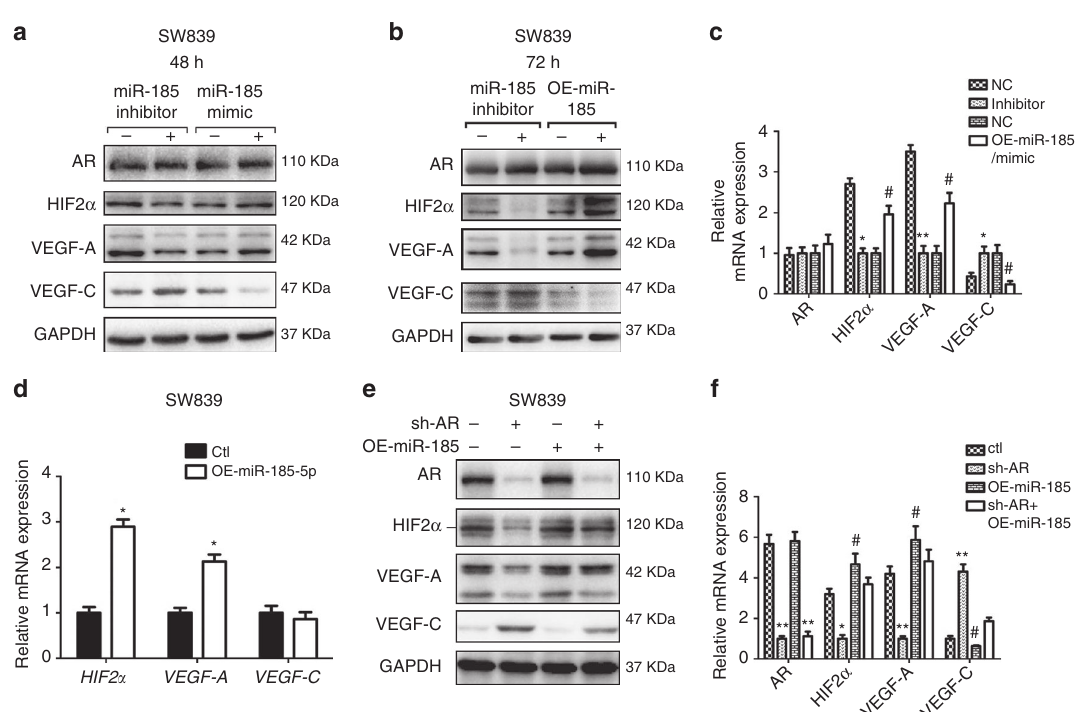
Fig. 5 The miR-185-5p regulates expression of VEGF-A and VEGF-C. a Immunoblotting of HIF2 α , VEGF-A, and VEGF-C with overexpressed or inhibited miR-185-5p in SW839 cells after 48 h treatment with miR-185-5p mimic or inhibitor. b Immunoblotting of HIF2 α , VEGF-A, and VEGF-C in SW839 cells after 72 h treatment with miR-185-5p overexpressing plasmid or inhibitor. c Statistical results of a , b . d qPCR of HIF2 α , VEGF-A , and VEGF-C after overexpressing miR-185-5p in SW839 cells for 48 h. e Immunoblotting of HIF2 α , VEGF-A, and VEGF-C with/without knockdown of AR and overexpression of miR-185-5p in SW839 cells. f Statistical results of e . Triplicate experiments were carried out in all experiments. *and # p < 0.05, ** p < 0.01 were considered statistically signi fi cant by t -test for two groups or ANOVA for more than two